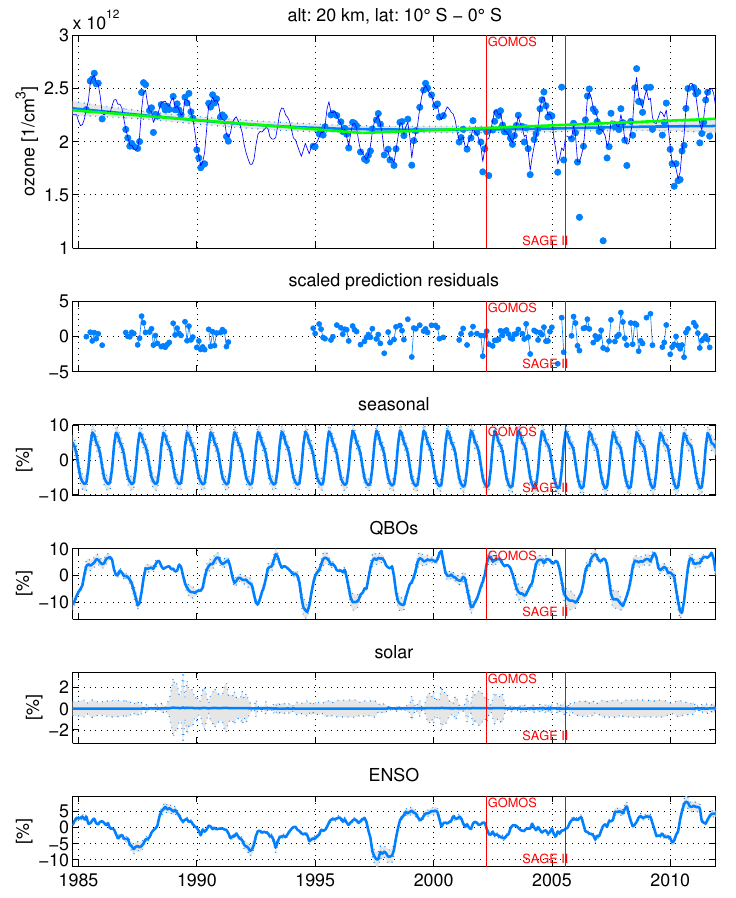
Figure 3. Some of the DLM model components for 10–0 ◦ S, 20km. The top panel has the observations and the level components as in Fig. 2. In addition, the piecewise linear regression model used by Kyrölä et al. (2013) is drawn with a solid green line. The second panel shows model residuals, scaled by the estimated residual standard deviation, i.e. the variability in the y axis direction should be approximately standard Gaussian N( 0 , 1 ) . The other panels show means and 95% probability envelopes (grey shading) of the DLM components related to seasonality and to the proxy variables – solar, QBO and ENSO – i.e. the original proxy variables multiplied by the estimated regression coefficients. For the proxy variables, the y axis scaling is the percentage of the total ozone variability, i.e. the ozone observations were scaled by their standard deviation, individually for each data set analysed. At 20km we see a large number of missing observations, some possible outliers, and a strong effect of the ENSO index. There is only a slight difference between DLM and linear models, however, although the latter does not include ENSO.